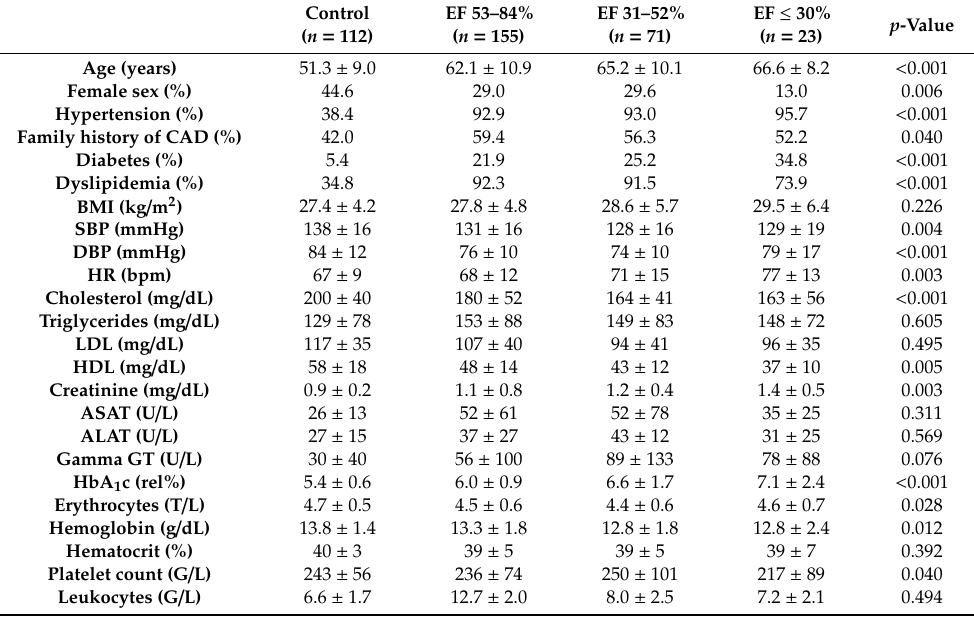
Table 1. Baseline characteristics.